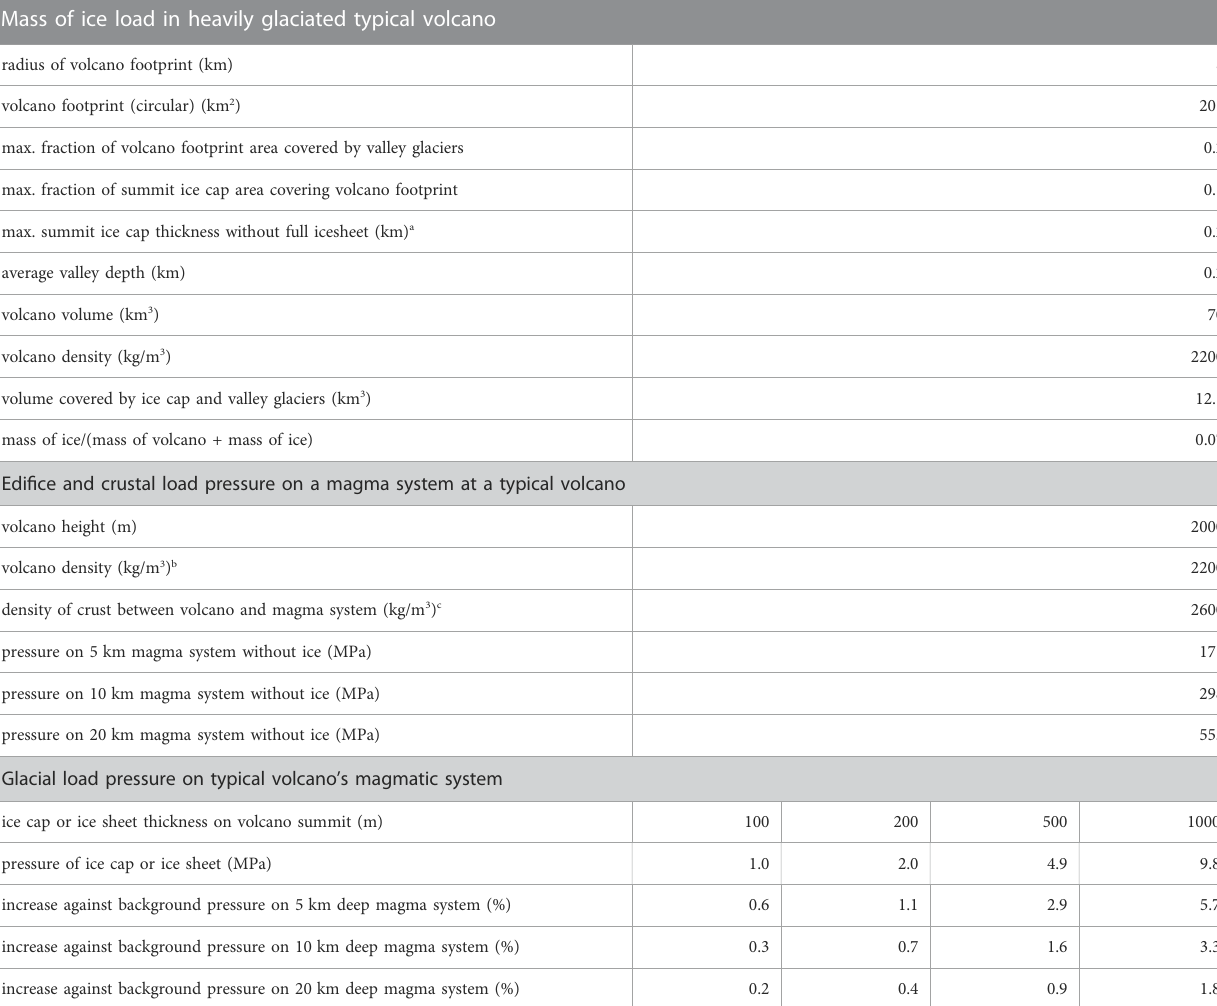
TABLE 4 Estimates of volume and the pressure applied by ice masses, a volcanic edi fi ce, and the crust on a magmatic plumbing system at 5, 10, and 20 km below the pre-volcanic datum (surface of the crust). Mass of ice load in heavily glaciated typical